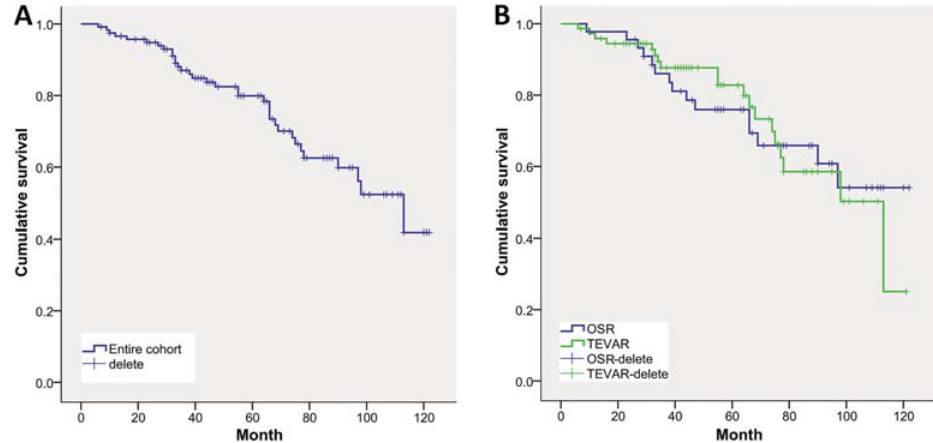
Figure 1. Kaplan-Meier analysis. A , The 10-year overall survival rate was 41.9% and the follow-up rate was 81.4%. B , No signi fi cant difference was found in the 10-year overall survival rate between open surgical repair (OSR) (56.7%) and thoracic endovascular aneurysm repair (TEVAR) (26.1%) in patients with type-B aortic dissection (log-rank, P = 0.953).